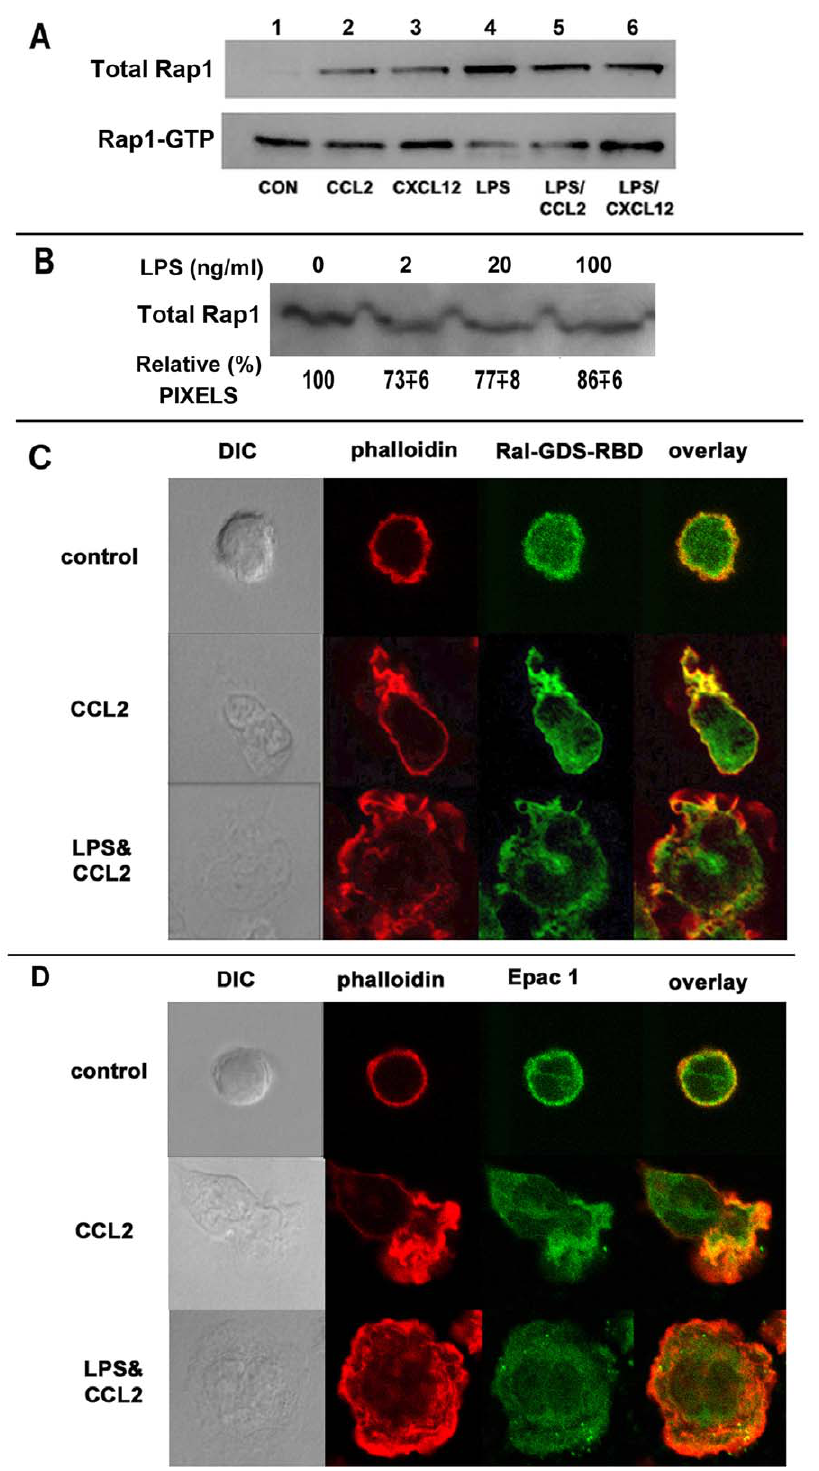
Figure 6. Whereas either chemokine or LPS treatment induced Rap-1 activation in monocytes, LPS treatment disrupted the leading edge localization of activated Rap1 GTPase and Epac-1, the Rap1 GEF. A ) 10 7 monocytes were treated with or without LPS (2 ng/ml) for 15 min followed by 2 min treatment with 20 nM CCL2 or CXCL12. Cytoplasmic extracts were prepared and activated (GTP + ) Rap1 was isolated using a commercial pull-down assay followed by SDS/PAGE and imunoblotting with anti-Rap1 mAb (upper). Cytoplasmic aliquots were analyzed directly for total cellular Rap1 (lower). B ) Rap-1 levels were not significantly altered during a 15 min incubation with increasing amounts (2–100 ng/ml) of LPS. Cytoplasmic aliquots were analyzed directly for total cellular Rap1. The relative pixel values for Rap1 represent averaged results from using monocyte from three donors. C ) LPS treatment abolished polarization of activated Rap1. Human monocytes on cover slips treated with or without LPS (2 ng/ml) for 15 min at 37 u C were stimulated with 20 nM CCL2 for 2 min. Cells were fixed, permeabilized and incubated with Ral-GDS RBD GST (Thermo